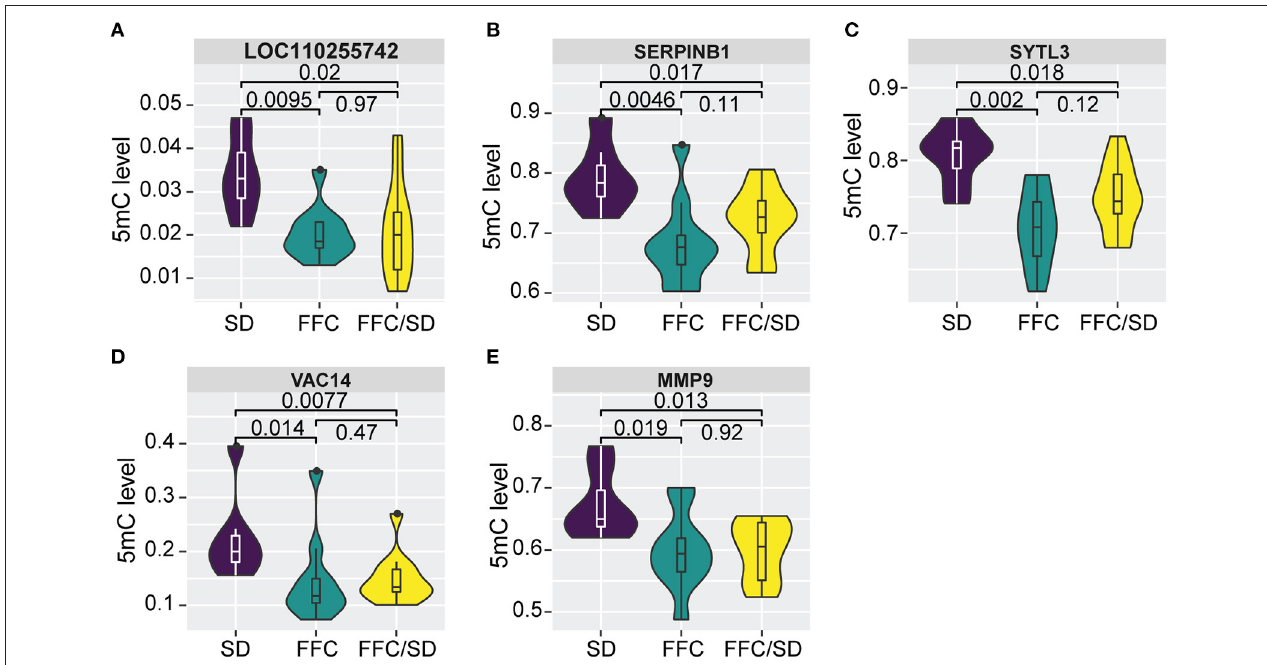
FIGURE 5 | Differential methylation profiles after diet reversion. (A–E) Boxplot of methylation level of promoter regions of LOC110255742 (A) , SERPINB1 (B) , SYTL3 (C) , VAC14 (D) , MMP9 (E) . P -values were calculated using Mann-Whitney U